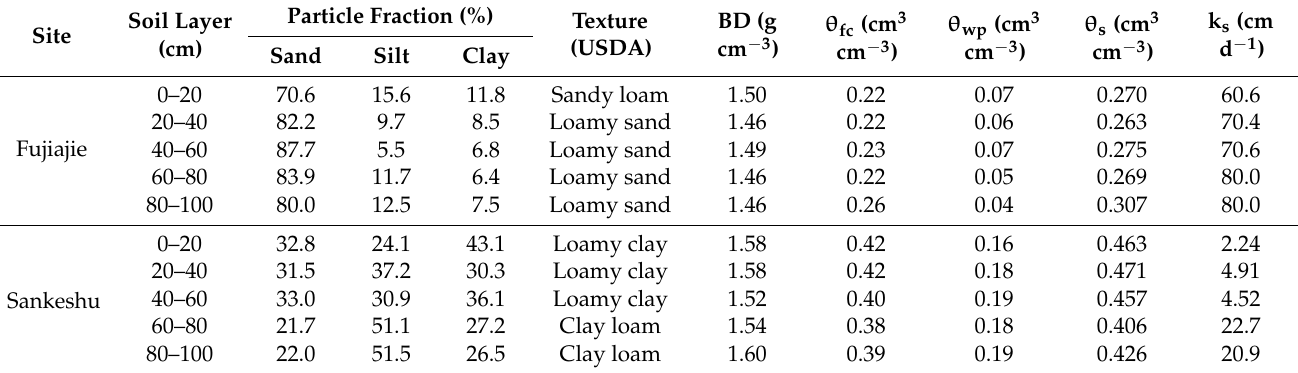
Table 5. Soil physical and hydraulic properties for soil profiles in two experimental